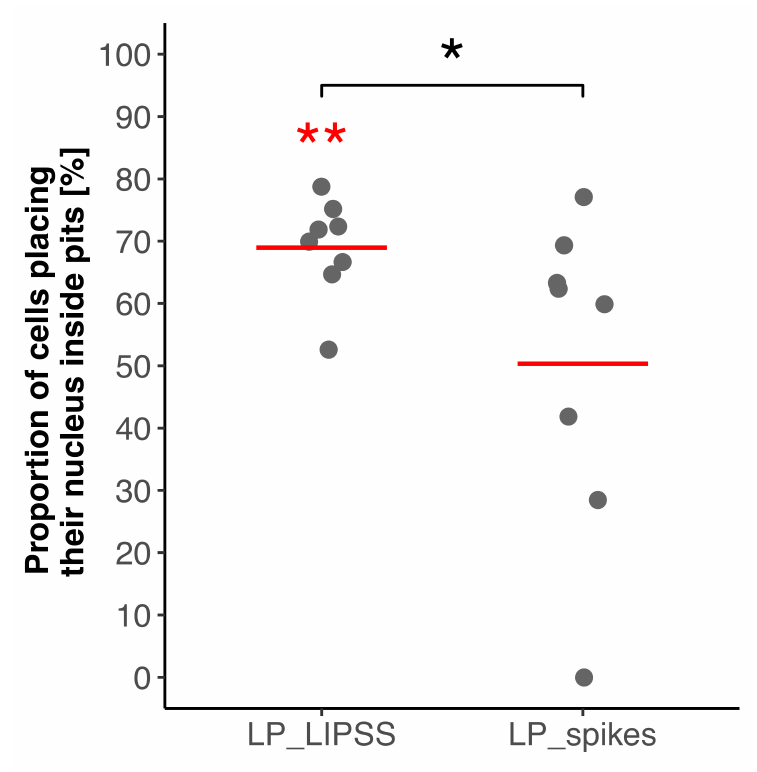
Figure 5. Quantification of nuclei proportion inside pits on laser-patterned surfaces 24 h after cell seeding. Values were normalized according to the proportion of pits area. Four di ff erent areas of each surface were analyzed and the displayed data correspond to duplicates of each condition (300 nuclei analyzed for LP_LIPSS and 494 for LP_spikes). Red lines denote mean values. The Mann–Whitney statistic test was performed. * p -value < 0.05, ** p -value < 0.01. Red asterisks denote significant di ff erences with the random theoretical value ( µ 0 =